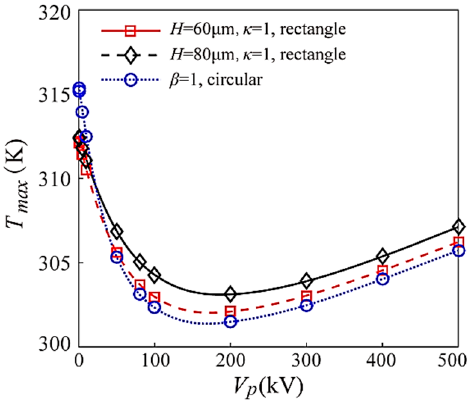
Figure 5. Effect of applied voltage on the maximum temperature of the Y-shaped microchannel heat sink with different geometries and configurations.